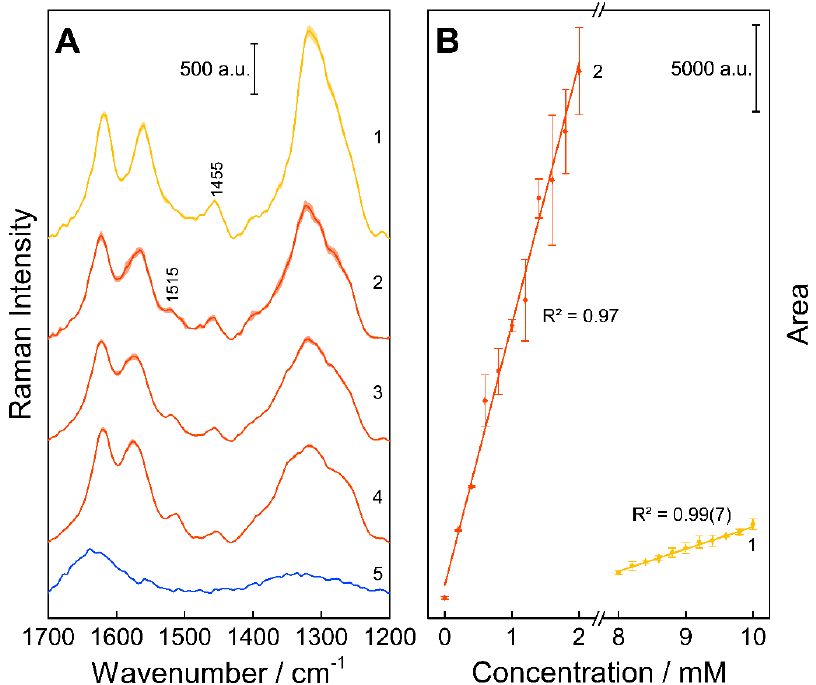
Figure 3. Representative resonance Raman spectra ( A ) of 10 mM TC (1) and 2 mM * EATC (2) used for predicting the contribution of the 10 mM solutions of the stress-treated drugs. Here, the severest conditions for temperature/humidity (23 days, 70% relative humidity and 70 °C (3)) and light treatment ( 12 Mlux ⋅ h (4)) are shown. Additionally, the water reference spectrum (5) can be found, which was used for the calculation of the difference spectra. The utilized signals for the quantification of the substances in the Raman spectra acquired with λ exc = 413 nm are marked. Small changes can be observed in the Raman peaks due to the treatments. The average Raman spectra and their deviation are depicted. Regression lines ( B ) with corresponding coefficients of determination for the quantification of TC (1) and EATC (2). The calibration points were defined with the peak area of the respective fitted Raman marker bands at 1455 and 1515 cm − 1 for TC and EATC using λ exc = 413 nm as the excitation wavelength and result in a good linear relation. *As mentioned earlier, a mixture of TC and EATC was used for quantification (10 + 0 mM up to 8 + 2 mM). Therefore, the Raman signal of TC is also present in (2).